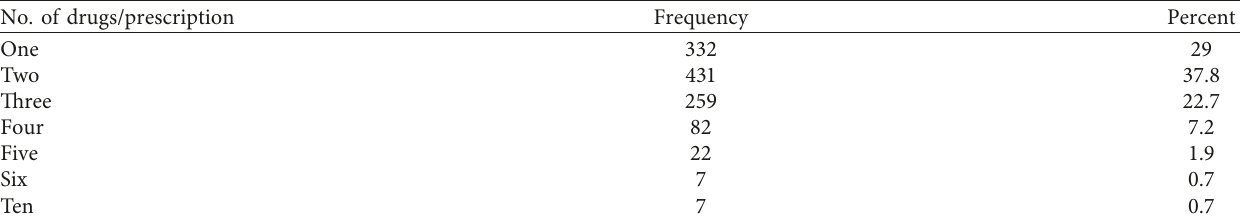
Table 2: Descriptive statistics of the overall prescription profile ( N � 1140) at the Edna Adan University Hospital, between August 28,